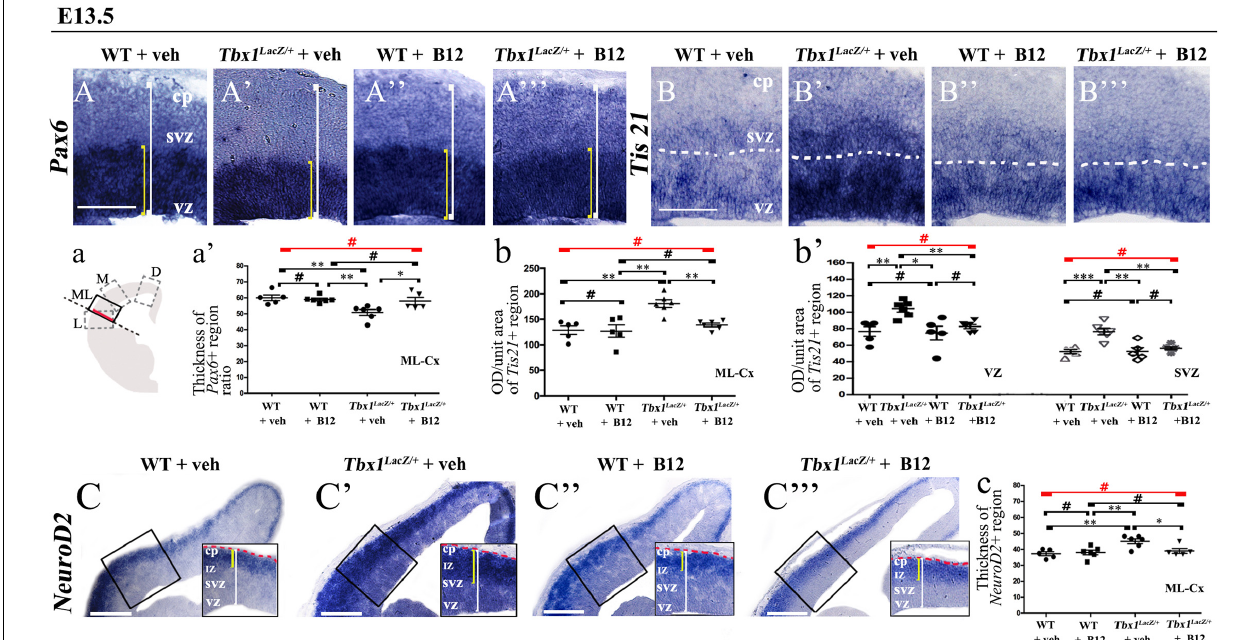
FIGURE 2 | Vitamin B12 treatment restores normal expression of cortical markers in Tbx1 heterozygous embryos. Panels show coronal sections of embryonic brains at E13.5. The cartoon, a, indicates the position of the ML-cortex in coronal brain sections (boxed area). The red line indicates the position where all measurements were made. (A,a) In situ hybridization of Pax6 (A–A”’) revealed thinning of the expression domain (yellow brackets) in vehicle-treated Tbx1 lacZ / + (heterozygous) embryos (A’) compared to vehicle-treated WT embryos (A,a) , which was rescued by B12 treatment (A”’,a) . (B,b,b’) In situ hybridization of Tis21 (B–B”’) showed increased expression (OD) in the ML-cortex of vehicle-treated Tbx1 lacZ / + embryos compared to vehicle-treated WT embryos (B) , including the VZ and SVZ (B’,b,b’) , which was rescued by B12 treatment (B”’,b,b’) . (C,c) In situ hybridization of NeuroD2 (C–C”’) showed increased expression in the ML-cortex of vehicle-treated Tbx1 lacZ / + embryos (C’,c) compared to vehicle-treated WT embryos (C) and extension of the expression domain (yellow brackets), relative to the total ventricular pial thickness (white brackets), which was rescued by B12 treatment (C”’,c) . Dashed red line defines the external edge of the cortical plate (CP). Scale bars, 100 µ m in all panels except (C) , which is 200 µ m. * P ≤ 0.05, ** P ≤ 0.01, *** P ≤ 0.001, error bars indicate mean ± SD, red horizontal bars with # not significant, n = 5–6 per genotype. VZ, ventricular zone; SVZ, subventricular zone; IZ, intermediate zone; CP, cortical plate; ML-Cx, medio-lateral cortex; D, dorsal; M, medial;